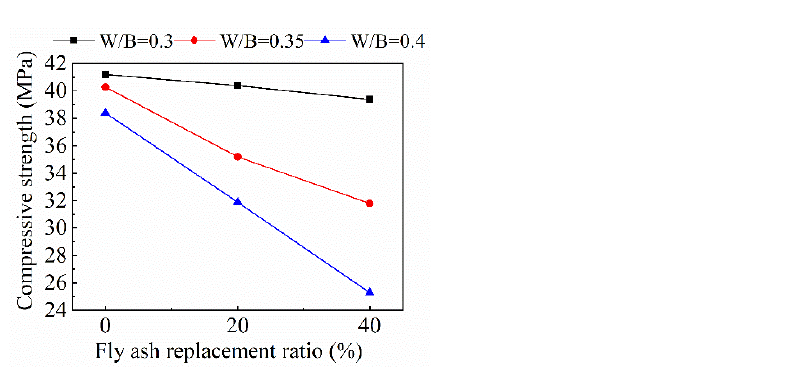
Figure 6. Variation of recycled mortar compressive strength with w / b ratio. RR represents replacement ratio of fly ash. 4. Mix Design and Properties of FRAC 4.1. Determination of Sand Ratio Generally speaking, the fine aggregate needs to fill the void between the coarse aggregate first, and then form mortar to wrap the surface of the coarse aggregate, so the sand ratio of FRAC can be calculated by the following two formulas. s (2) where, V g , V s are the volumes of the coarse aggregate and fine aggregate per cubic concrete, respectively. P g is the void ratio of the RCA, which is 52.8% in this test. γ is the mortar rich coefficient, which is the ratio of the volume of mortar to the void volume of coarse aggregate; γ = 1.1–1.4 for ordinary concrete [28]. In the test, the value of γ is taken as 1.3. β s is the sand ratio. m g , m s are the mass of RCA and RFA per cubic FRAC. The values of m g and m s are equal to the product of the volume and apparent density of RCA and RFA per cubic FRAC. From Table 4, the apparent densities of RCA and RFA are 2734.8 kg/m 3 and 2594.7 kg/m 3 . Putting these data into the Equation (2), β s = 39.4%. Therefore, the sand ratio in this test is taken as 40%. Then, based on the w / b ratio and sand-cement ratio obtained from the performance test of mortar, the mix design of FRAC is calculated. 4.2. Mixture Design of FRAC According to the optimum sand-cement ratio determined in the recycled mortar test, the sand ratio was 40%, the water consumption per cube was 200 kg, and the water-